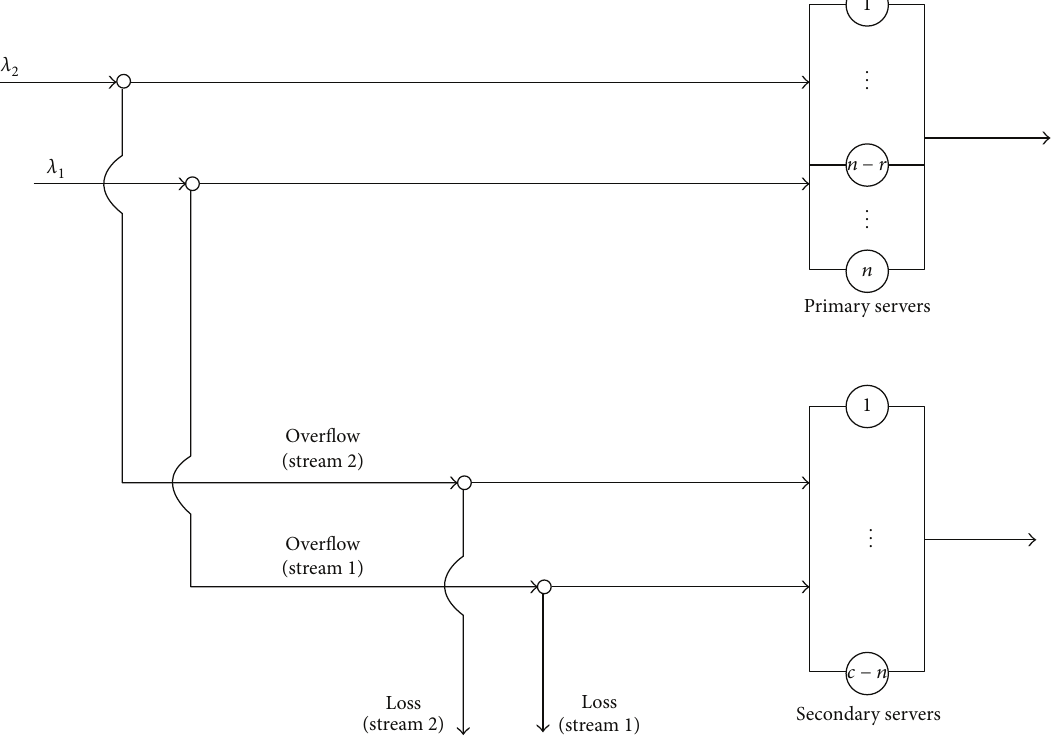
Figure 1: Block diagram of the STR